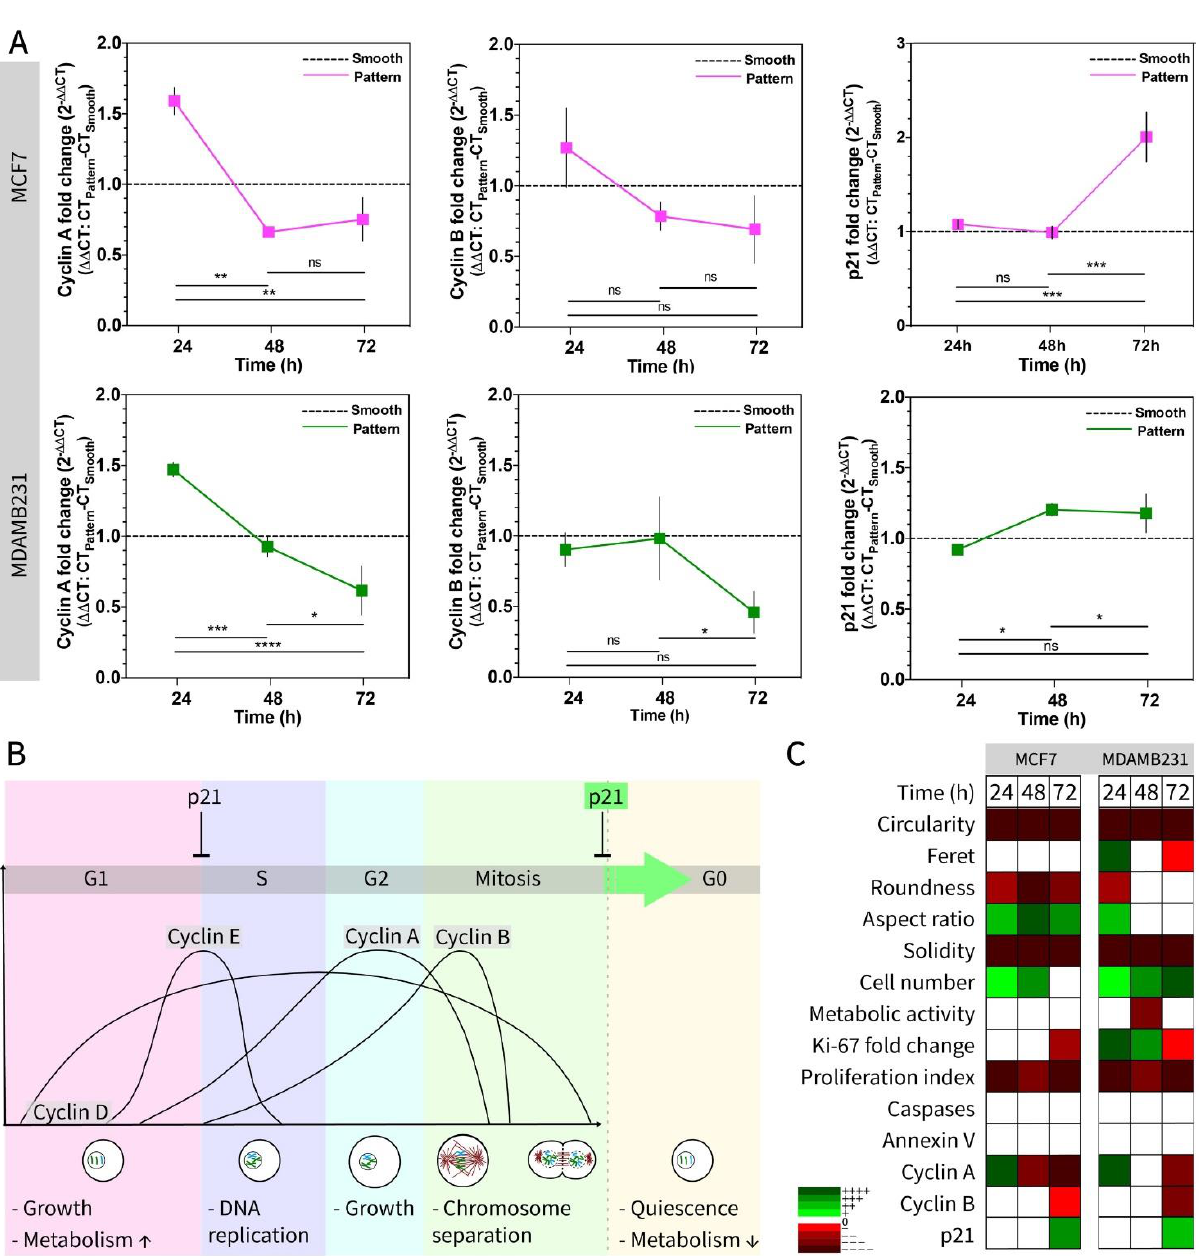
Figure 5. Cell cycle gene expression, scheme, and heatmap of the all metabolic and proliferative parameters of the MCF7 and MDAMB231 cells analyzed on Ch-Pattern at 24, 48, and 72 h of culture. ( A ) Cyclin A, B, and p21 expression of the MCF7 and MDAMB231 cells on Ch-Pattern. Results are normalized to Ch-Smooth and GAPDH expression ( ∆∆CT , see Materials and Methods (Heading 2)) (one-way ANOVA, MCF7: p CyclinA < 0.0001, p CyclinB = 0.0073, p p21 < 0.0001; MDAMB231: p CyclinA < 0.0001, p CyclinB = 0.0005, p p21 = 0.0027; * p < 0.005, ** p < 0.001, *** p < 0.0005, **** p < 0.0001). ( B ) Schematic of the cell cycle control genes. ( C ) Heatmap of the metabolic activity, image, and PCR analyses of the MCF7 and MDAMB231 cells cultured on the chips for 24, 48, and 72 h. The heatmap is constructed using statistical analysis data of the Ch-Pattern compared to Ch-Smooth. (* p < 0.005, ** p < 0.001, *** p < 0.0005, **** p < 0.0001; +/green: increase/upregulation, − /red: decrease/downregulation, white: no significant change).